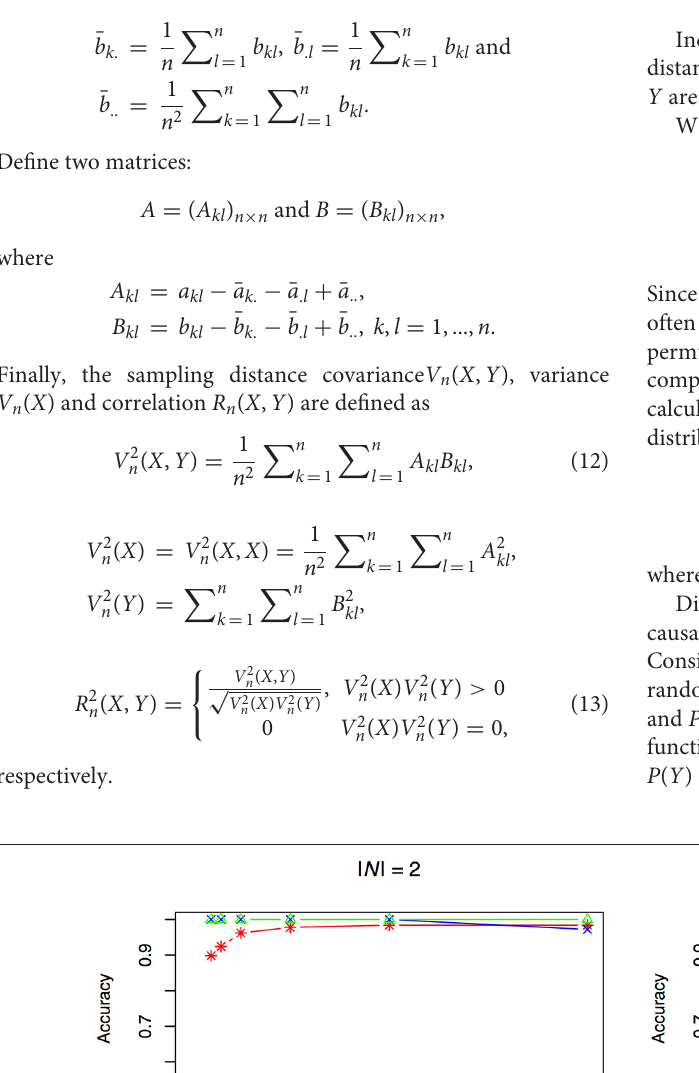
2. Simulation scenario 2, |N| =